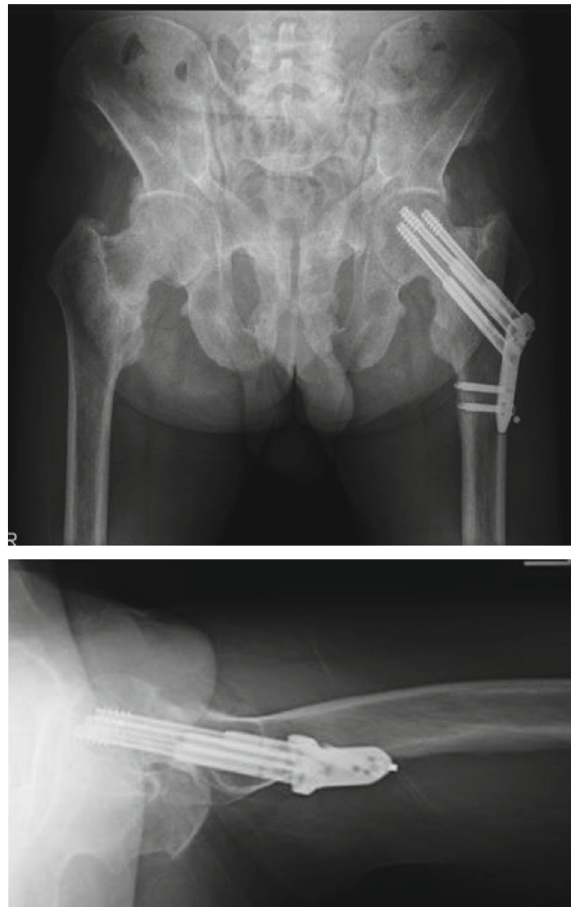
Figure 6: Radiographs taken 15 months after surgery revealing that the fracture achieved bone